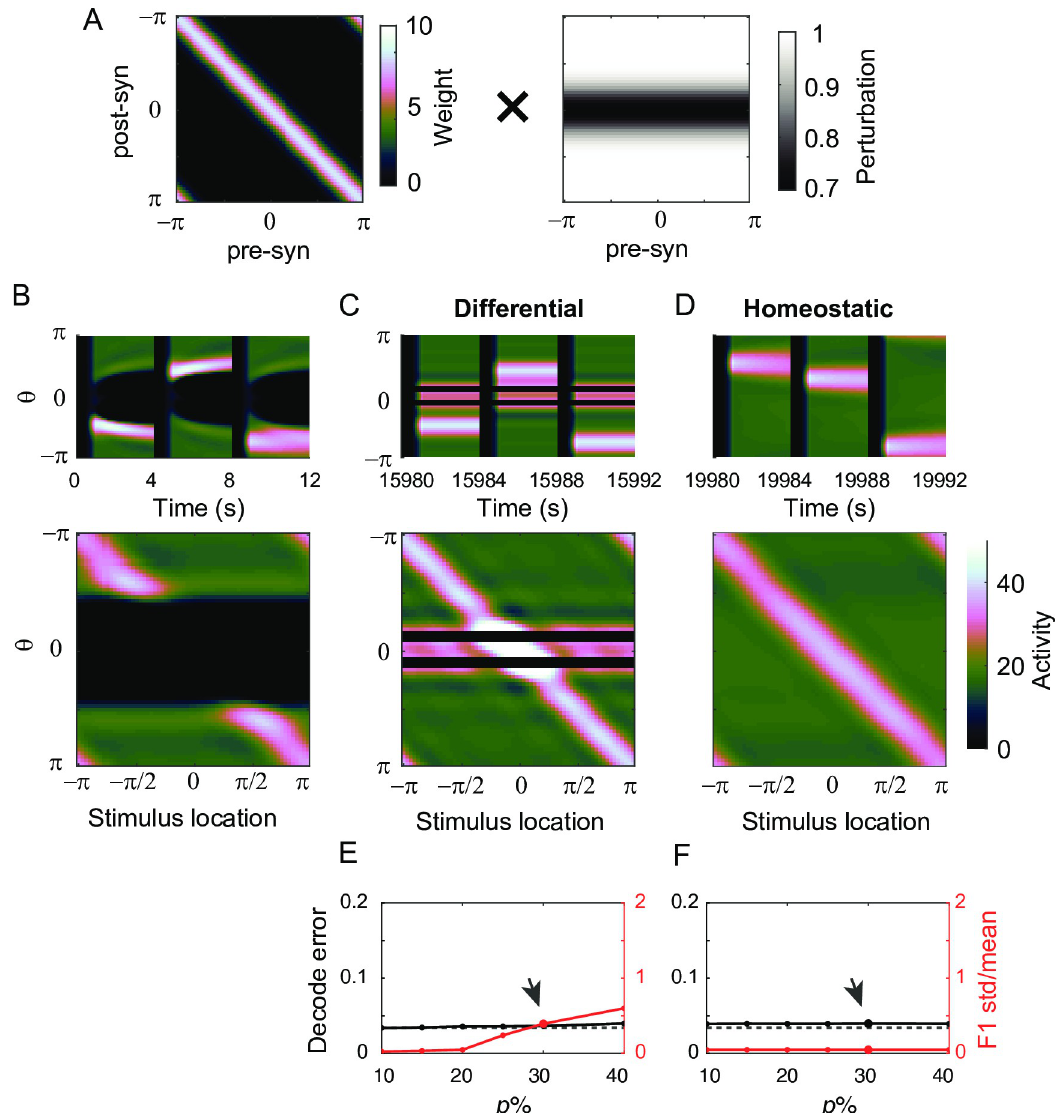
Fig 9. The effect of differential and homeostatic plasticity under postsynaptic perturbations. A: Schematics of postsynaptic perturbations where the rows of the connectivity matrix are multiplied by different scaling factors. Perturbation is centered at θ = 0 and bell-shaped. B: Activity pattern under 30% postsynaptic perturbations before any plasticity. C-D: Activity pattern shaped by the differential (C) and homeostatic (D) plasticity. The learning parameters used here are α d = 10 − 3 , α h = 10 − 8 , and r 0 = 20. E-F: Decoding errors (black) and normalized deviation of spatial selectivity (red) for different perturbation strengths after applying differential (E) and homeostatic (F) plasticity. Perturbation strength marked by arrow is shown in C-D.